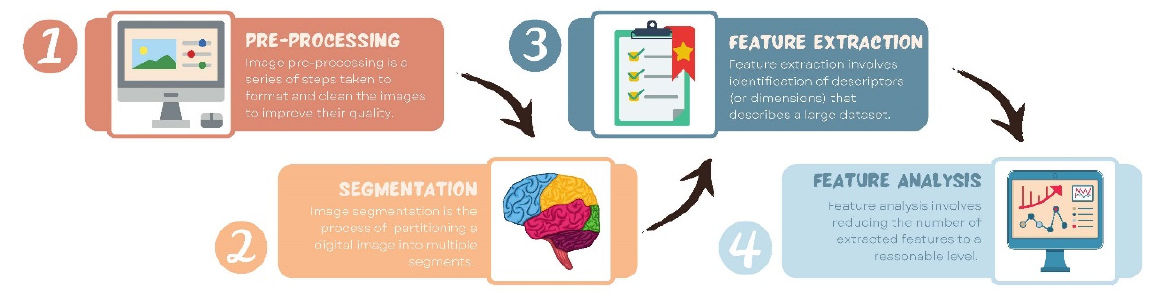
Figure 1. Illustration of the radiomics workflow steps: preprocessing, segmentation, feature extrac- tion, and feature analysis.